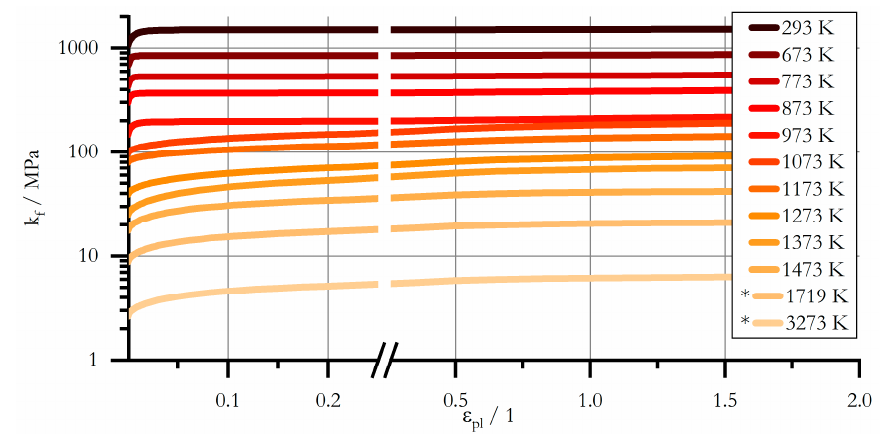
Figure 5. Flow stress curves of 22MnB5 after rapid heating from heat-treated state; * artificial curves.